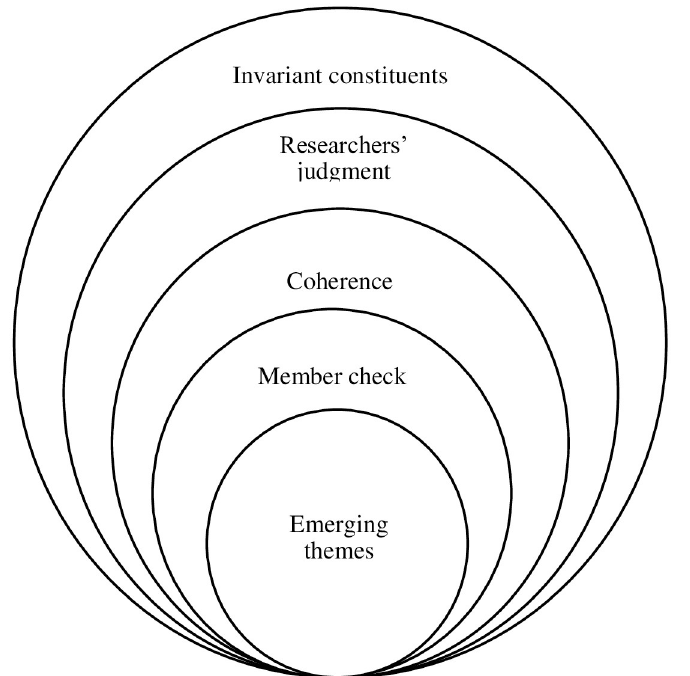
Fig 1. Steps to acquire